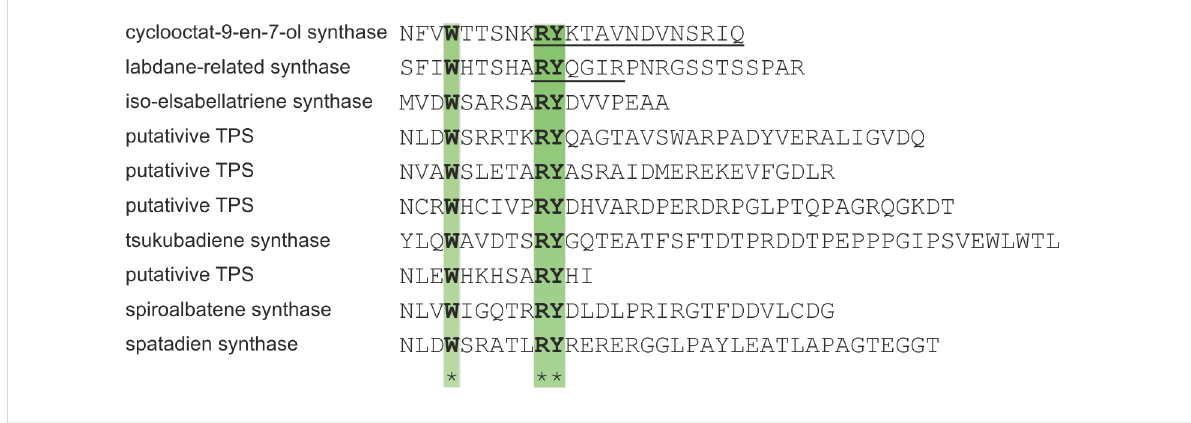
Figure 6: The WXXXXXRY motif in protein sequences of diterpene TPS from different bacteria. Highlighted is the WXXXXXRY motif in green. Under- lined sequences refer to crystal structures of the respective diterpene TPS in the closed conformation, with a structured C-terminus. Cyclooctat-9-en- 7-ol synthase (WP_093468823), S. melanosporofaciens; labdane-related diterpene synthase (WP_019525557), Streptomyces K155; iso-elsabella- triene synthase (WP_003963279), Streptomyces clavuligerus ; terpene synthase (WP_046708564.1), Streptomyces europaeiscabiei ; terpene synthase (WP_012394883), Myobacterium marinum ; diterpene synthase (BAP82229), Streptomyces sp. ND90; tsukubadiene synthase (EIF90392), Streptomyces tsukubaensis NRRL 18488; terpene synthase (ZP_00085244), Pseudomonas fluorescens PfO-1; spiroalbatene